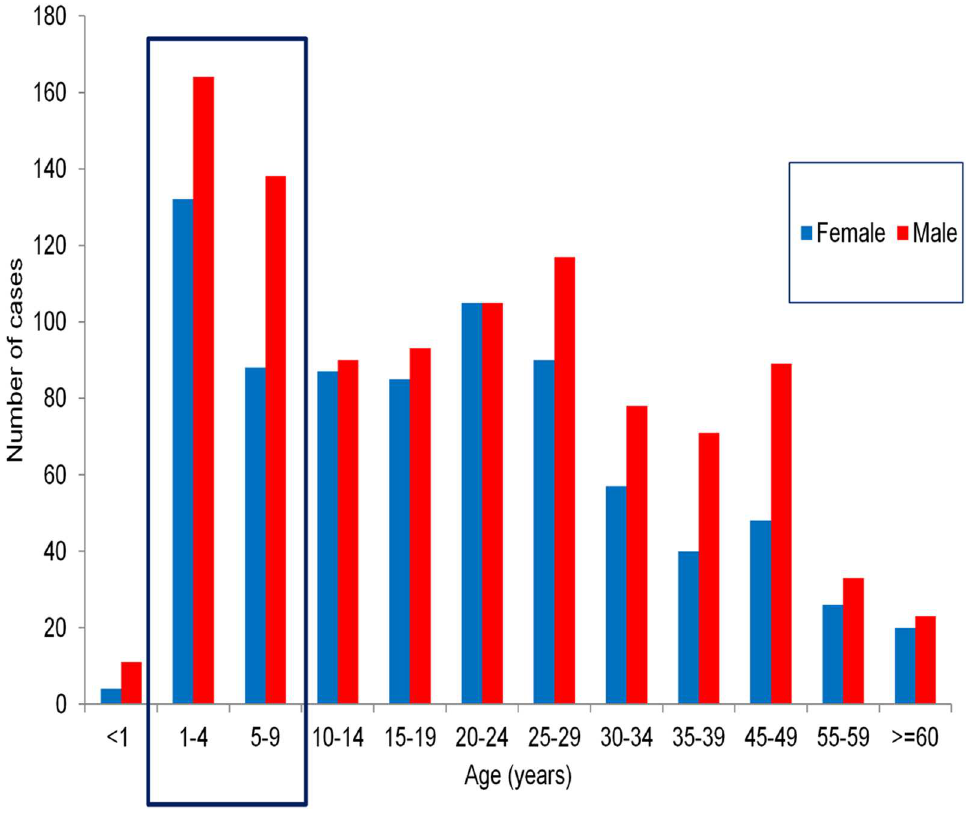
Fig 8. Reported cholera casesby age group and gender in fishing villages in Uganda, 2011–2015.